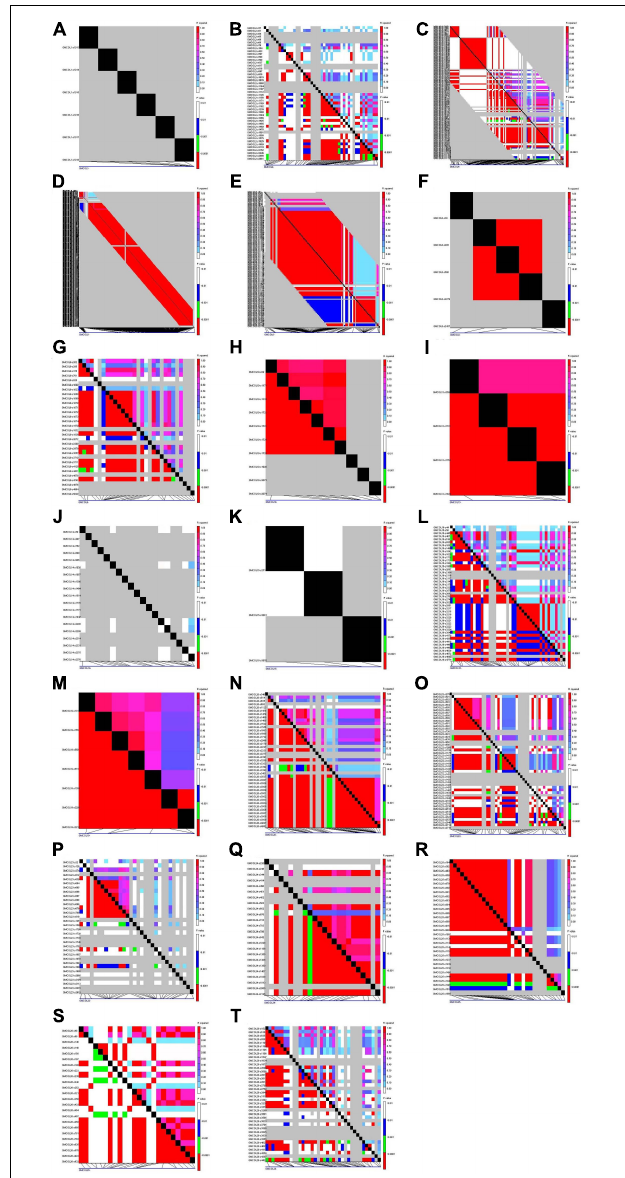
FIGURE 3 | Linkage disequilibrium of GmCOL family genes in soybean. (A) Linkage disequilibrium (LD) of GmCOL1 . (B) LD of GmCOL2 . (C) LD of GmCOL4 . (D) LD of GmCOL5 . (E) LD of GmCOL6 . (F) LD of GmCOL8 . (G) LD of GmCOL9 . (H) LD of GmCOL10 . (I) LD of GmCOL13 . (J) LD of GmCOL14 . (K) LD of GmCOL15 . (L) LD of GmCOL16 . (M) LD of GmCOL19 . (N) LD of GmCOL20 . (O) LD of GmCOL22 . (P) LD of GmCOL23 . (Q) LD of GmCOL24 . (R) LD of GmCOL25 . (S) LD of GmCOL26 . (T) LD of GmCOL28